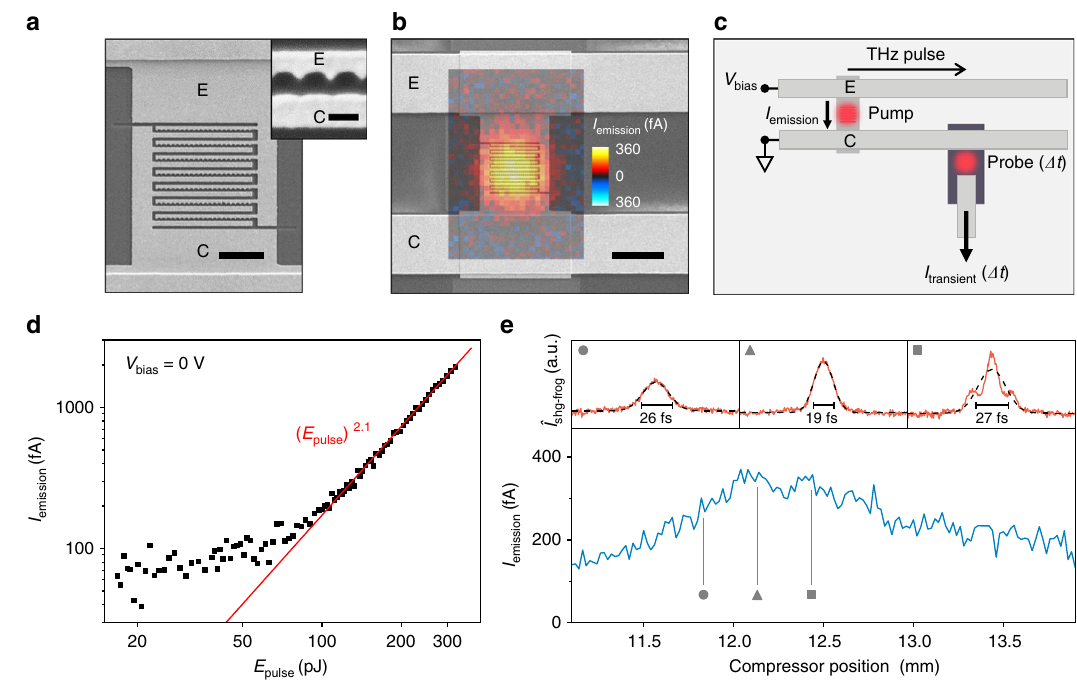
Fig. 1 Femtosecond photoemission in nanoscale junctions and THz on-chip circuits. a Scanning electron microscope (SEM) image of Ti/Au contacts and asymmetric nanojunctions with the emitter (collector) denoted as ‘ E ’ ( ‘ C ’ ). Scale bar, 2 µ m. Inset: Close-up showing the asymmetry between the emitter and collector. Scale bar, 200 nm. b Lateral map of the unipolar photoemission current I emission at zero bias V bias across asymmetric nanojunctions (overlaid plot), which are contacted by two Ti/Au striplines (outer SEM image). Scale bar, 5 µ m. c Schematic of the on-chip THz time-domain circuit with optical femtosecond pump and probe pulses triggering the electronic read-out. I emission describes the time-integrated current, while I transient captures the time- resolved electromagnetic transients in the striplines at a time delay Δ t . In all shown experiments, V bias = 0 V. d Non-linear I emission vs laser pulse energy E pulse with a power law fi t (red line). e Lower graph shows I emission vs laser compressor position at a fi xed E pulse = 150 pJ. The three upper insets show the second-harmonic generation frequency-resolved optical gating (SHG-FROG) intensity Î shg-frog for three given compressor positions denoted by a circle, triangle, and square. All measurements are performed at 77 K and in